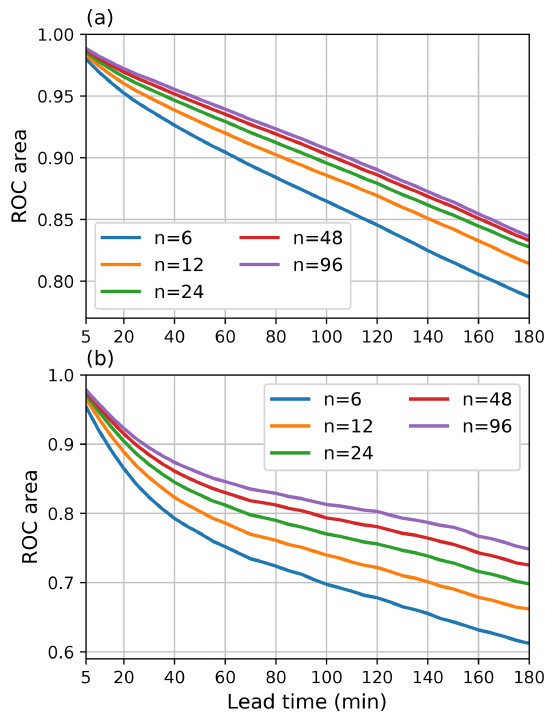
Figure 13. ROC areas for (a) 0.1mmh − 1 and (b) 5mmh − 1 thresh- olds with different ensemble sizes as a function of lead time during the MeteoSwiss events listed in Table 8.